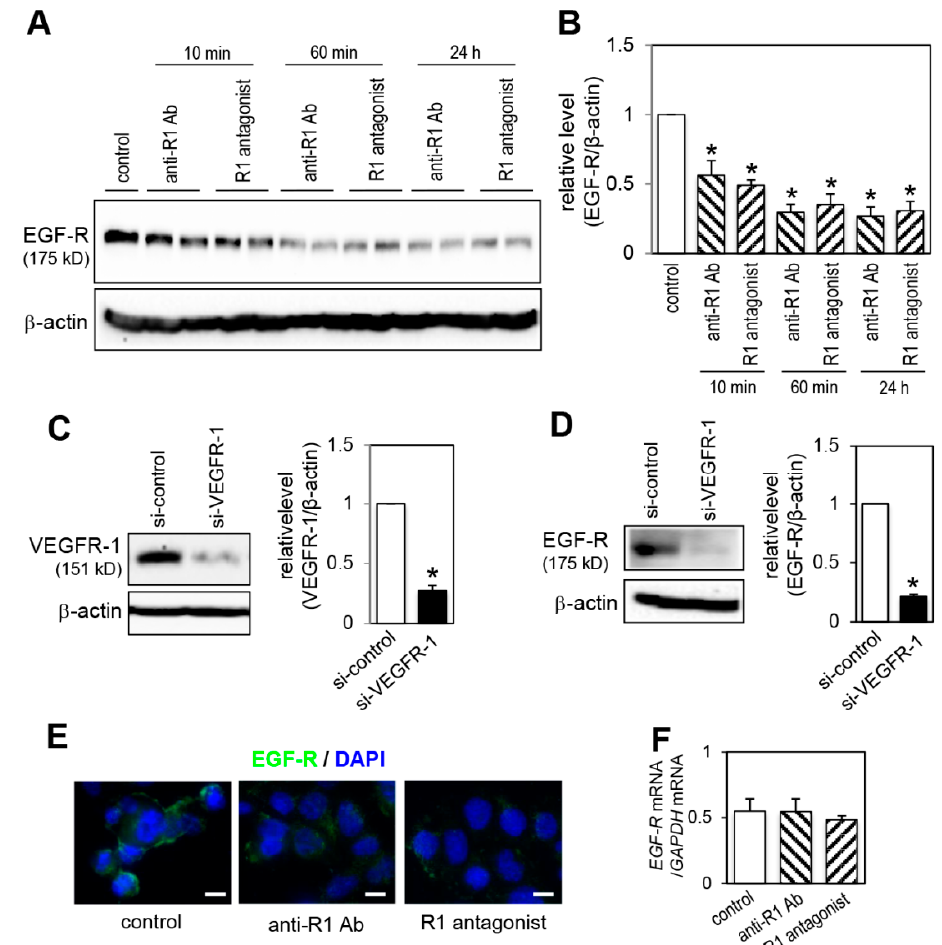
Figure 6. VEGFR-1 blockade decreases EGF-R expression. ( A ) Cells were treated with anti-R1 Ab and R1 antagonist for the indicated times, or with a control IgG for 24 h (indicated by control). EGF-R protein levels were determined by immunoblot analysis. The levels of β -actin are shown as a loading control. ( B ) Quantification of EGF-R levels normalized to β -actin from three independent experiments. * p < 0.01, statistically significant decrease compared with the control cells. ( C , D ) Cells were transfected with the indicated siRNA for 24 h. Levels of VEGFR-1 protein ( C , left) and EGF-R protein ( D , left) were determined by immunoblot analysis. Quantification of VEGFR-1 levels ( C , right) and EGF-R levels ( D , right) normalized to β -actin from three independent experiments. * p < 0.01, statistically significant decrease compared with the si-control-transfected cells. ( E ) Immunofluorescent staining with cell surface EGF-R. After cells were treated with anti-R1 Ab, R1 antagonist or control IgG for 1 h, cell surface EGF-R was stained as described in legend to Figure 2E. Scale bar = 10 µ m. ( F ) Cells were treated with anti-R1 Ab, R1 antagonist or control IgG for 12 h. Expression levels of EGF-R mRNA were determined by RT-qPCR analysis. Values were normalized for the amount of GAPDH mRNA ( n = 5, means ± SD).